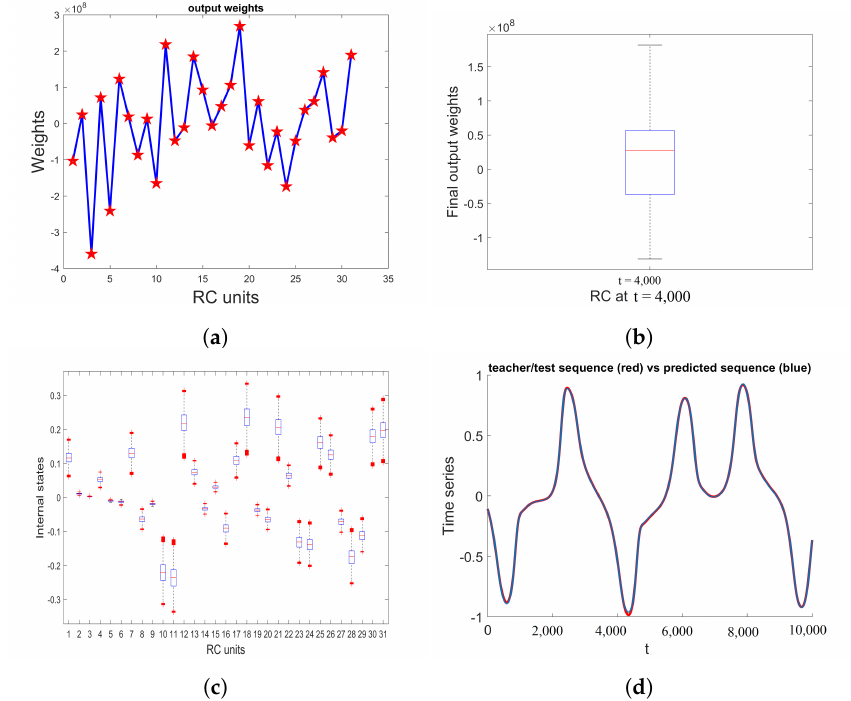
Figure 6. Training and prediction results of the RC model for z ( t ) state variable of the model (1) at σ = 1. The 70% of input data are used as teacher sequence, whereas the last 30% of the data are set as validation test data. ( a ) The weights of RC nodes after the completion of training. ( b , c ) The spread of the weights of RC units illustrated using box-and-whisker plot. ( d ) The training and test data in red color vs. predicted data in blue